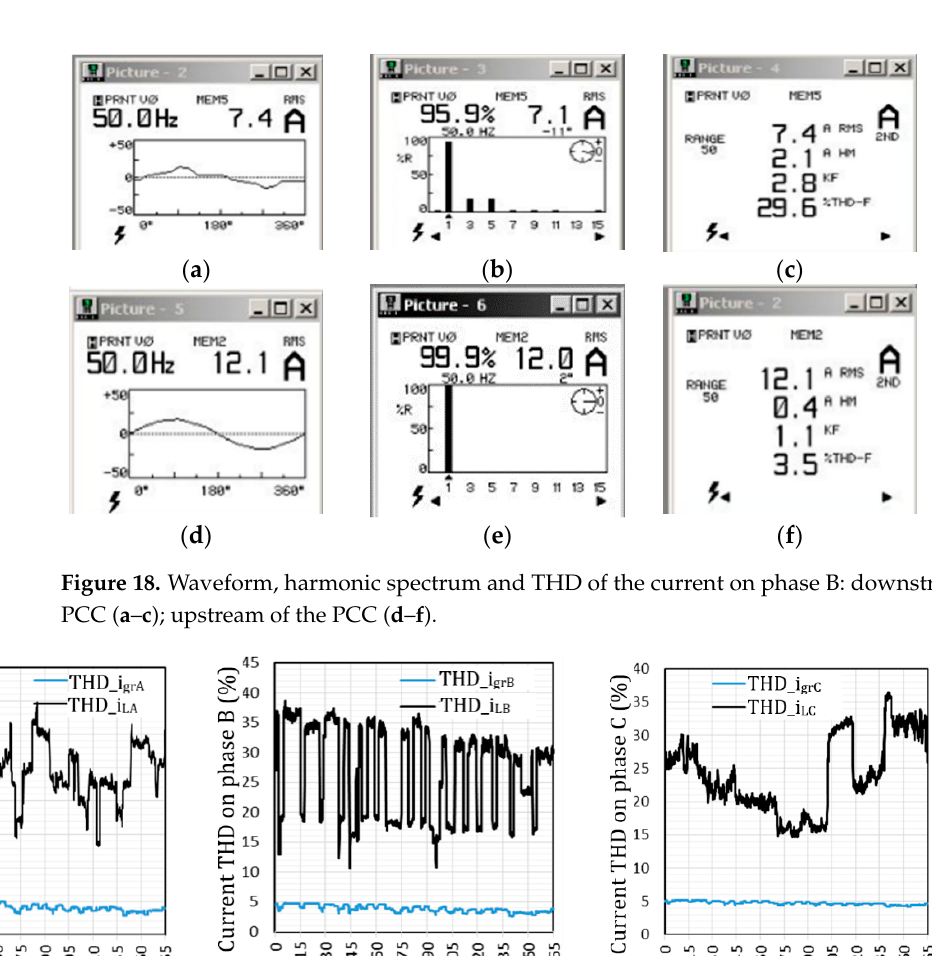
Figure 19. Evolutions of current distortion factors on phase A ( a ), phase B ( b ) and phase C ( c ): downstream of PCC (in black); upstream of the PCC (in blue).